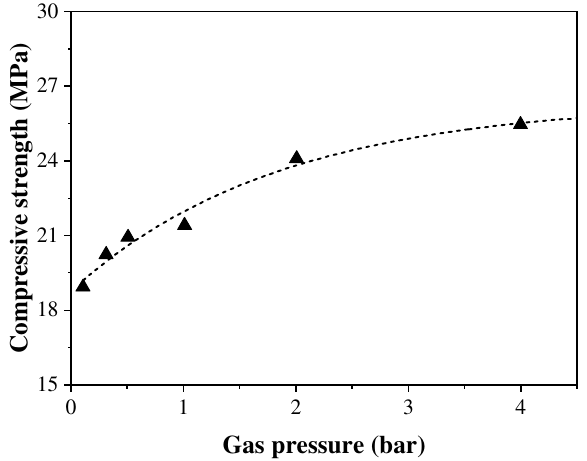
Figure 4. Influence of CO 2 pressure and concentration on carbonation curing [44].